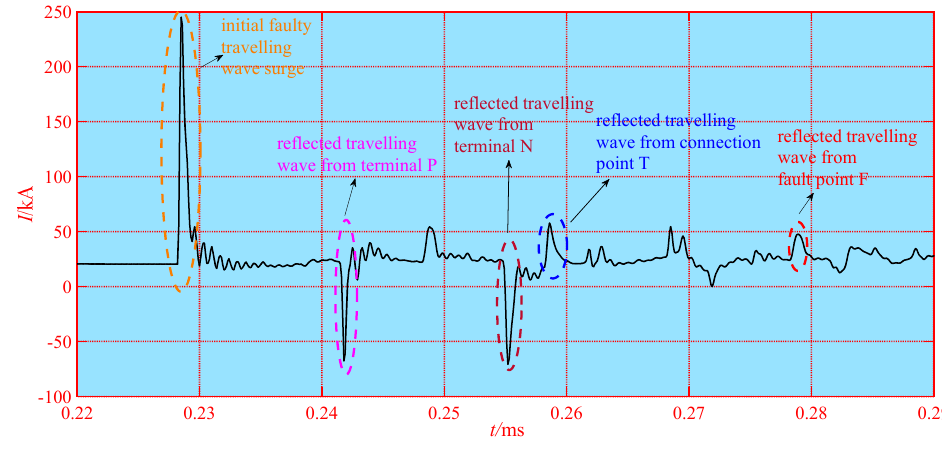
Figure 14. Travelling wave arrive sequence.